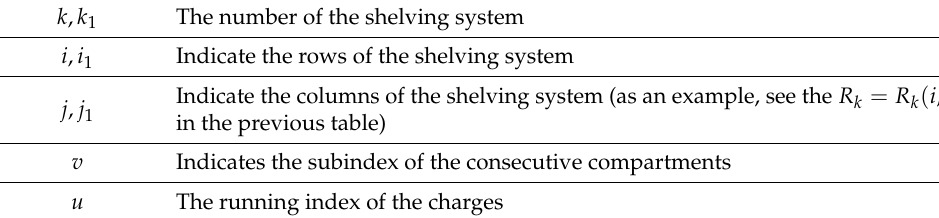
Table 2. Table of indexes.